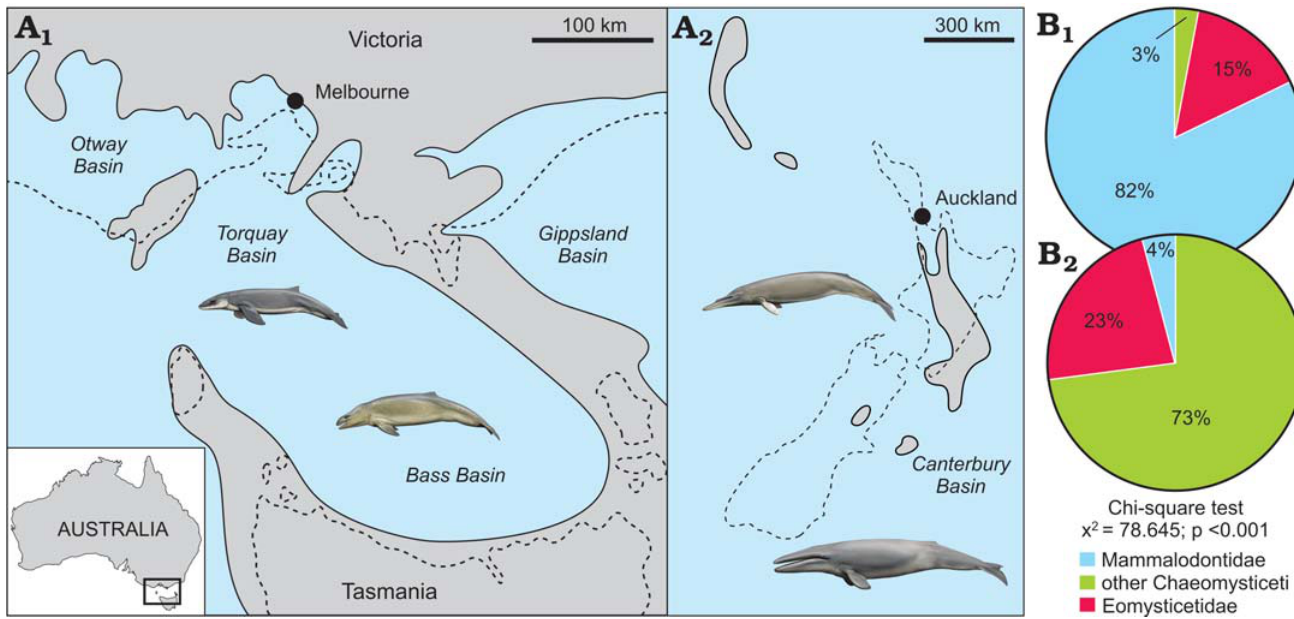
Fig. 2. Comparison of Australasian late Oligocene baleen whale assemblages: south-eastern Australia (A 1 , B 1 ) and New Zealand (A 2 , B 2 ). A . Late Oligocene palaeogeographical reconstruction. B . Differences in mysticete assemblage composition. Note the widespread inundation of New Zealand. Dashed lines in A delineate the modern coastline without compensating for late Neogene Alpine Fault movement. Palaeogeographical reconstructions are based on King et al. (1999), King (2000), Holdgate and Gallagher (2003). Drawings of whales by Carl